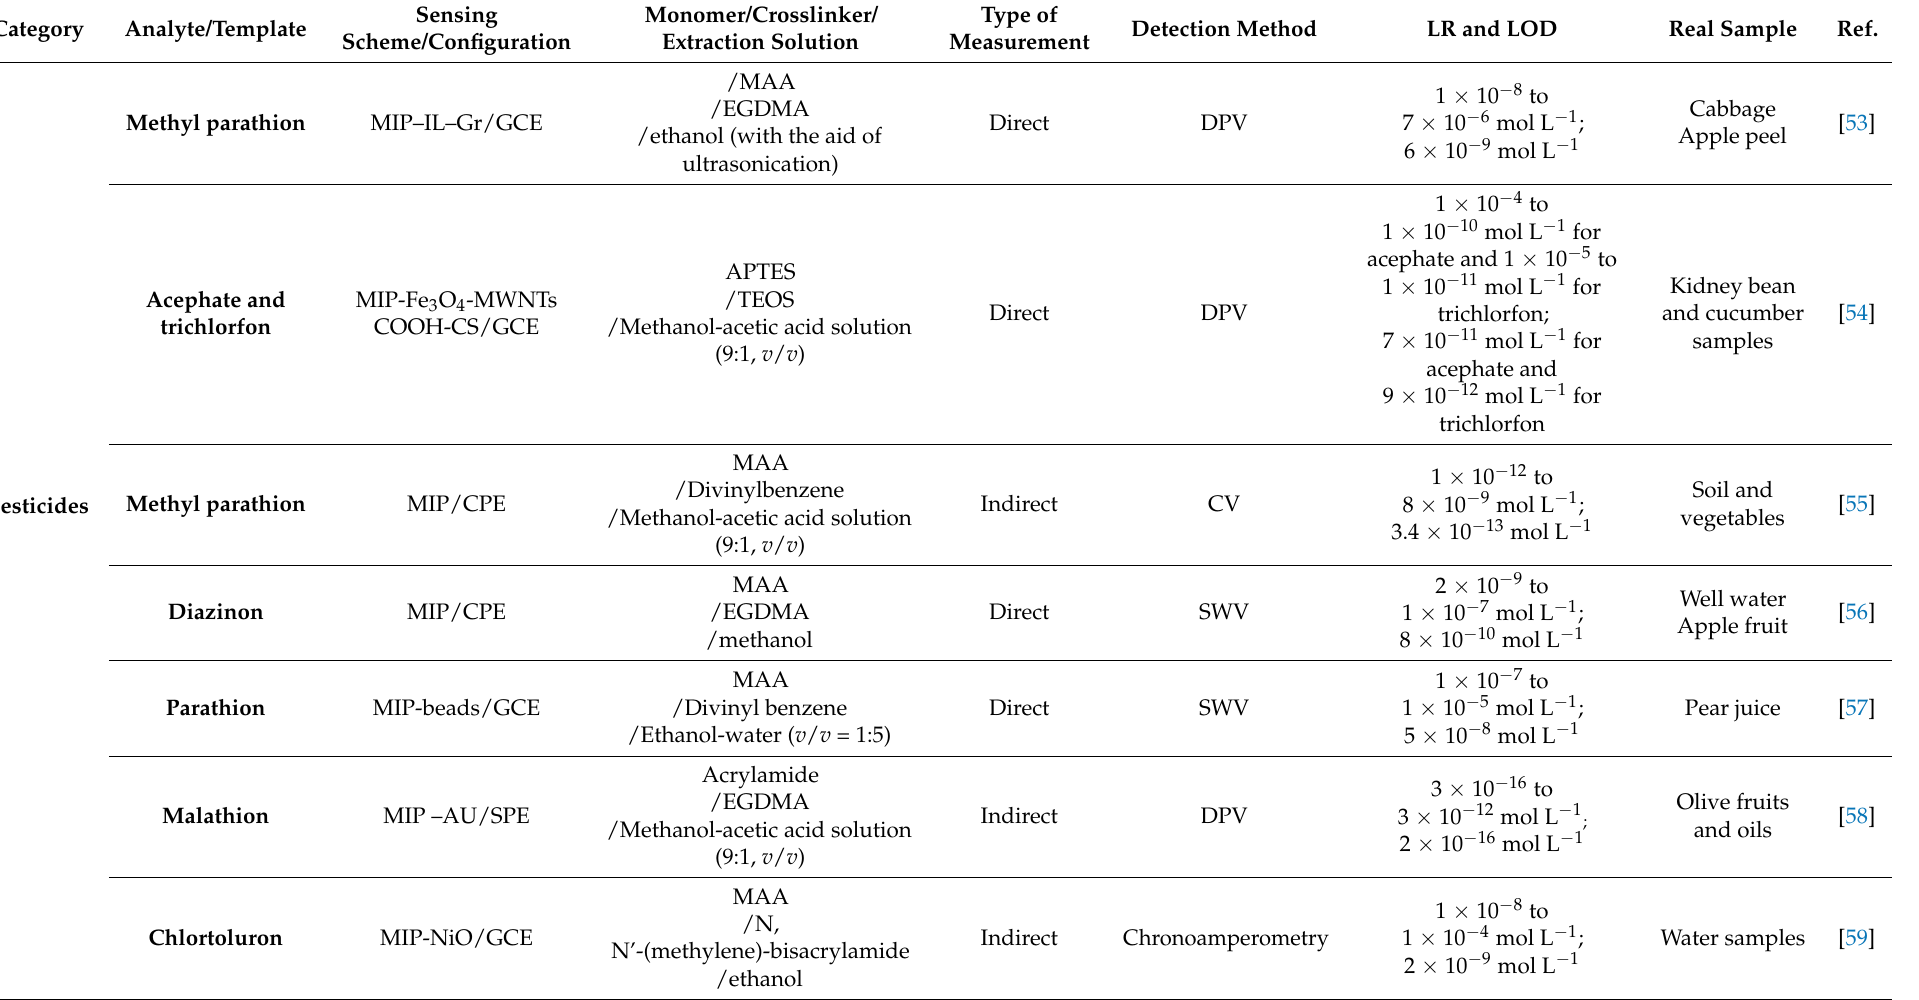
Table 1. Chemically synthesized MIPs-combined electrochemical sensors for food contaminants